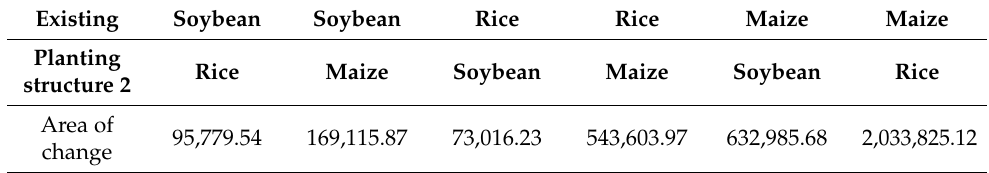
Figure 10. Comparison map of existing cultivated land and optimized areas. Table 9. Area changes of maize, rice, and soybeans before and after optimization